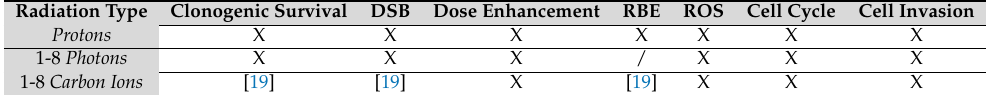
Table 1. Summary of the experiments performed in this work and in the previous one